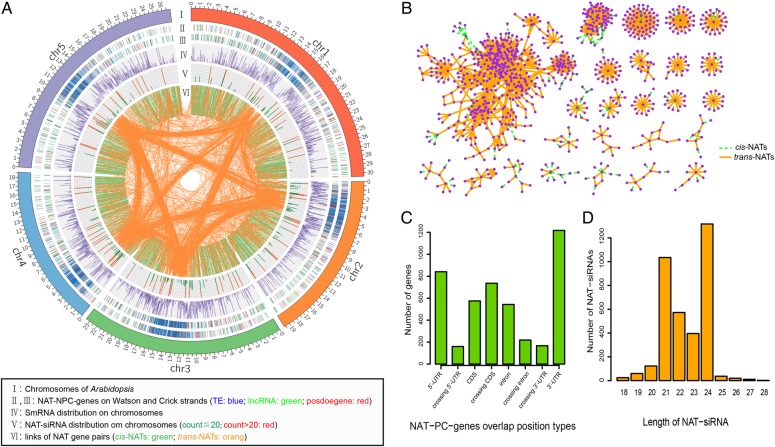
NATs in Arabidopsis. (A) NAT genes and NAT-siRNAs in chromosomes. From outermost to innermost, the first track demonstrates Arabidopsis chromosomes, the second and third tracks show the NAT genes on Watson and Crick strands, respectively, the fourth and fifth tracks show the distributions of all smRNAs and NAT-siRNAs, innermost links demonstrate the NAT pairs’ loci in chromosomes. (B) The network of NAT pairwises. Node means gene and edge means relationship of NAT pairs. (C) The number of protein-coding NAT genes with different overlapping positions. (D) The number of NAT-siRNAs with different lengths. This figure is available in black and white in print and in colour at DNA Research online.